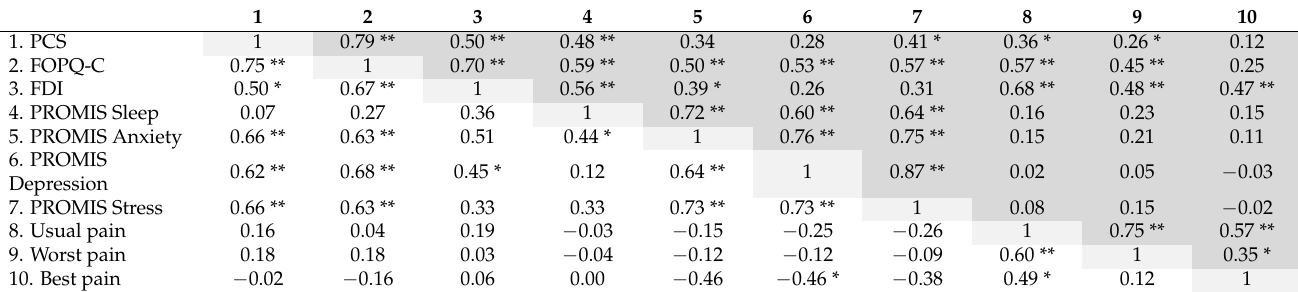
Table 3. Bivariate Spearman’s Correlation Coefficients across Study Outcomes by AL Risk Status ( ≤ 2: Unshaded; >2: